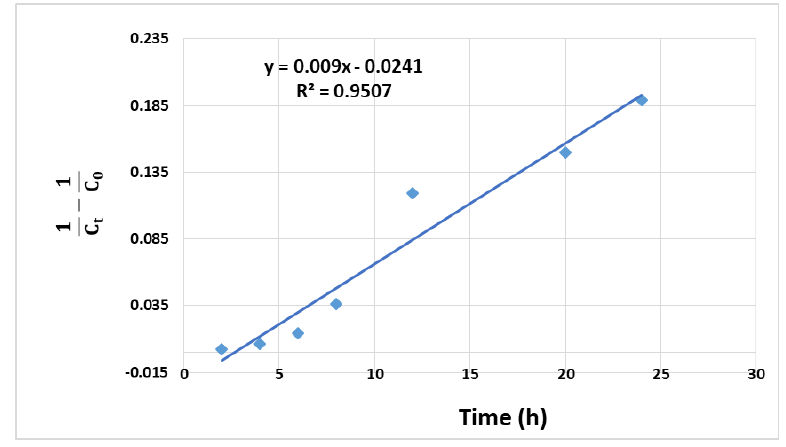
Figure 13. Model of the second-order apparent kinetics.